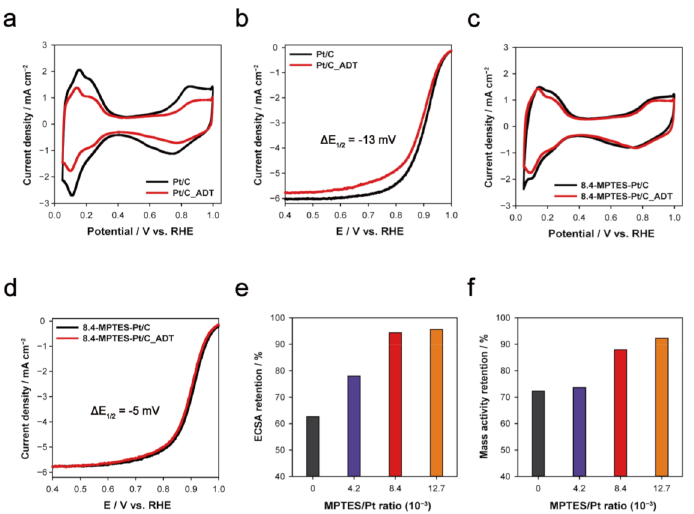
Figure 5. CV and ORR polarization curves before and after an accelerated degradation test (ADT) for ( a ), ( b ) Pt/C and ( c ), ( d ) 8.4-MPTES–Pt/C. Retention of ( e ) ECSA and ( f ) mass activity for MPTES–Pt/Cs with different MPTES/Pt